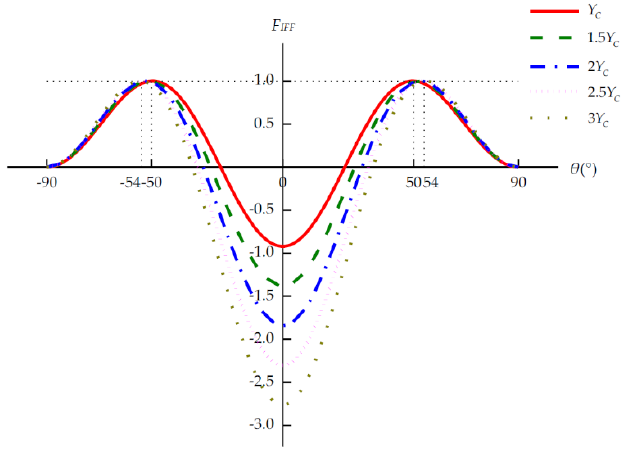
Figure A1. F IFF – θ relation for IM7 / 8552 under σ 2 = − Y is